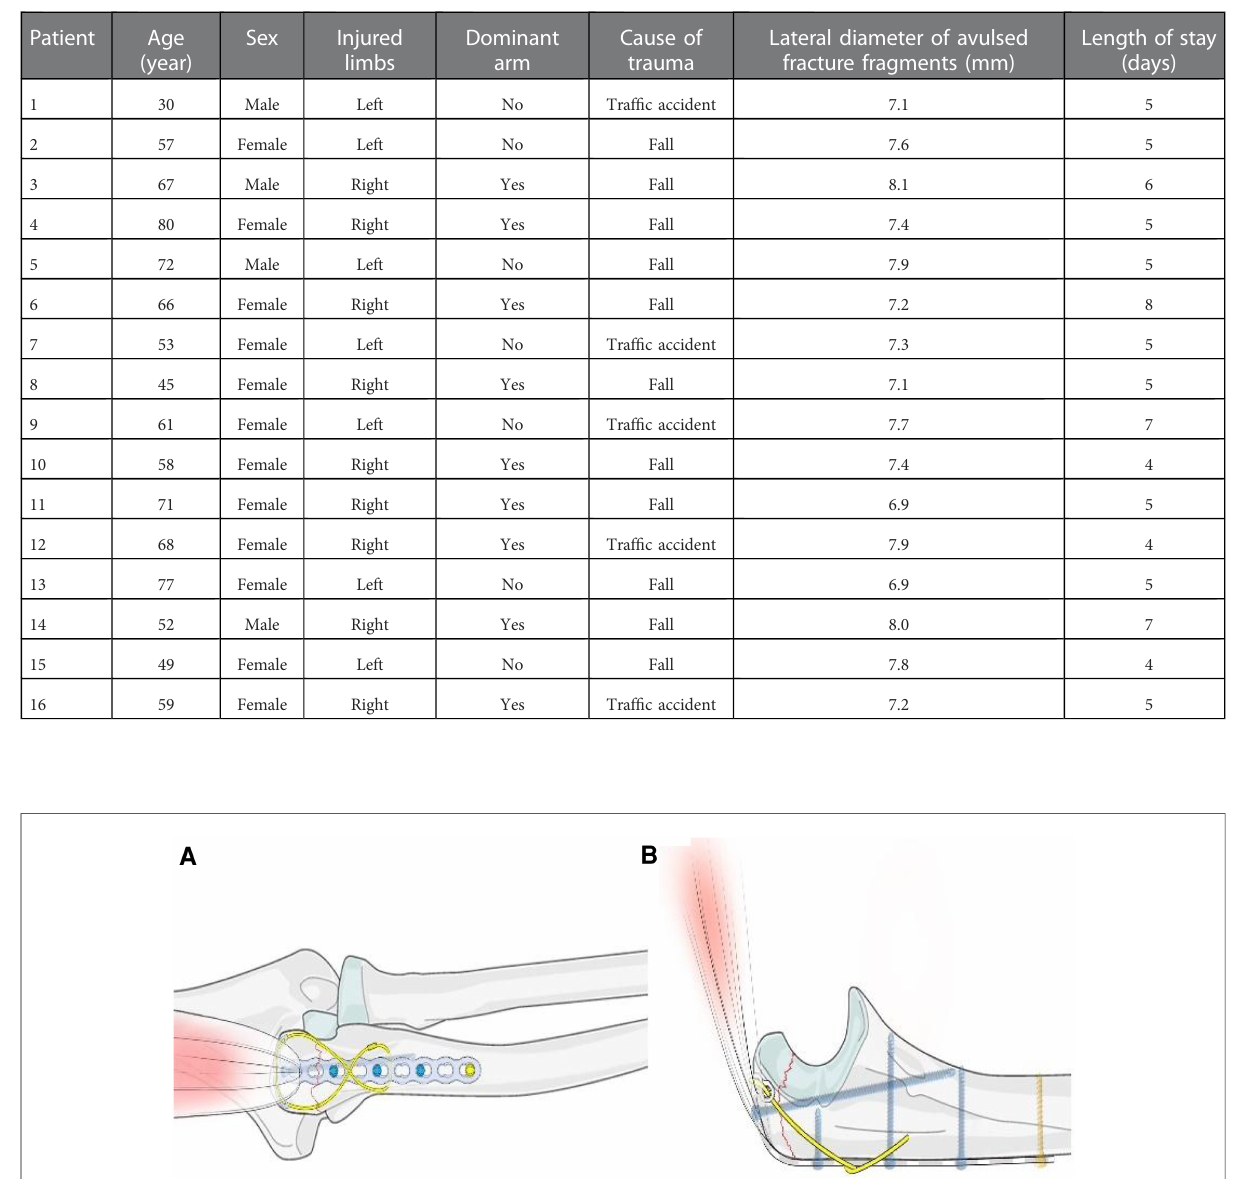
TABLE 1 Demographic data and general information.